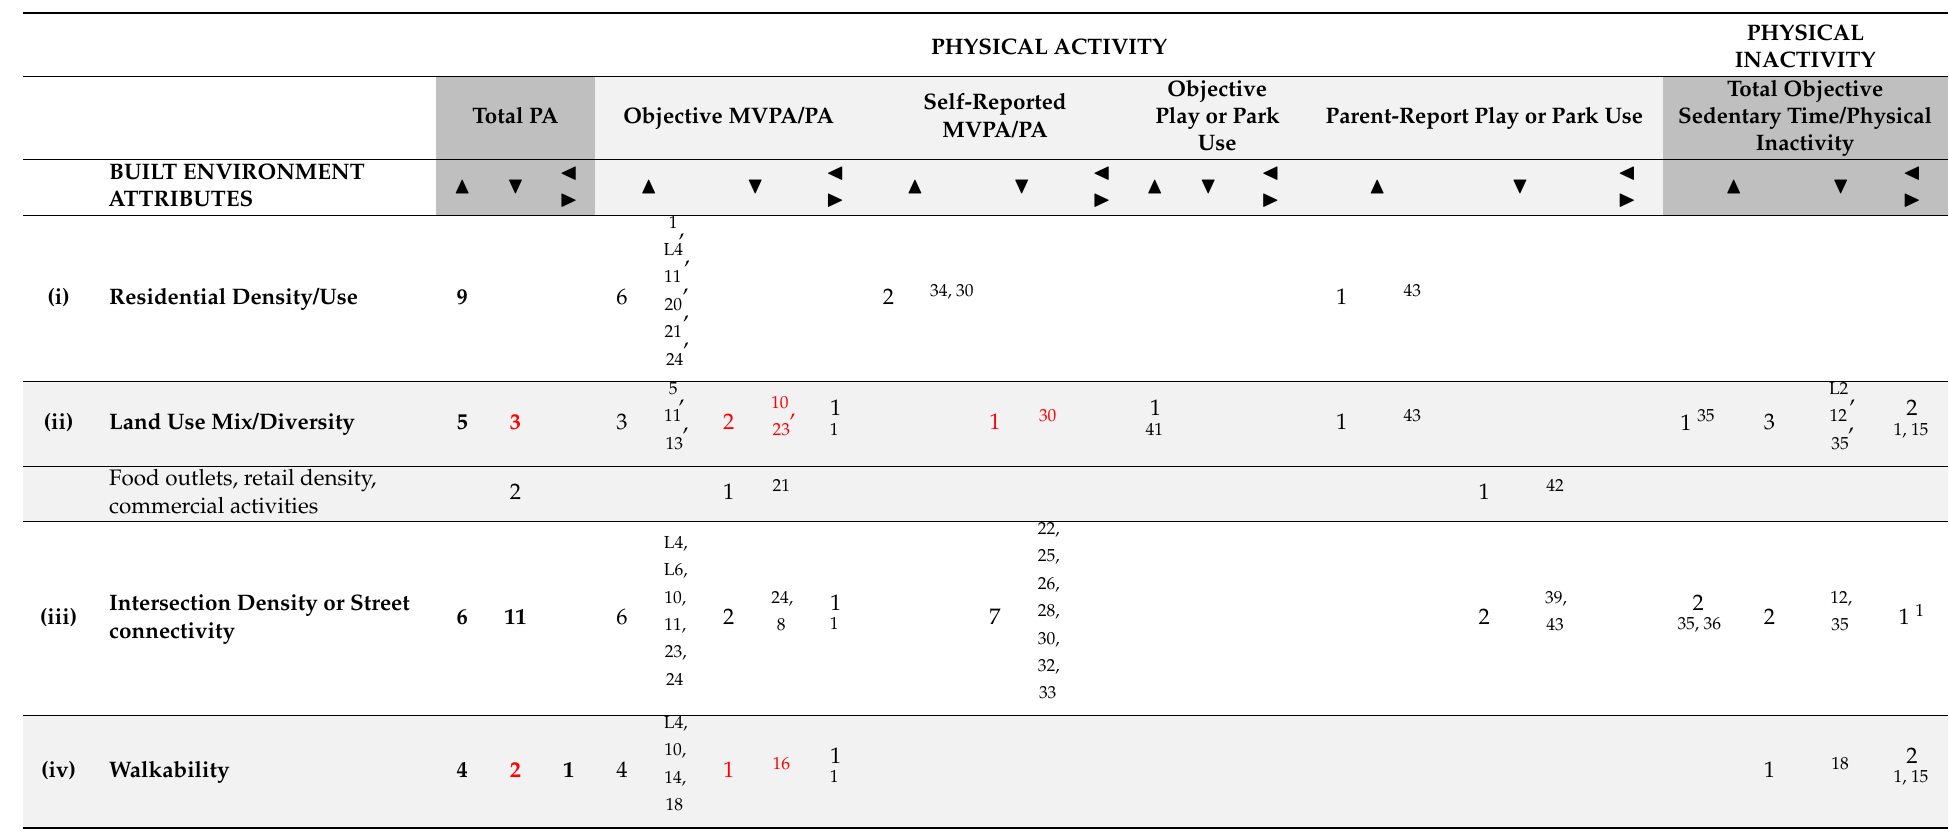
Table 3. Built environment and physical activity associations.